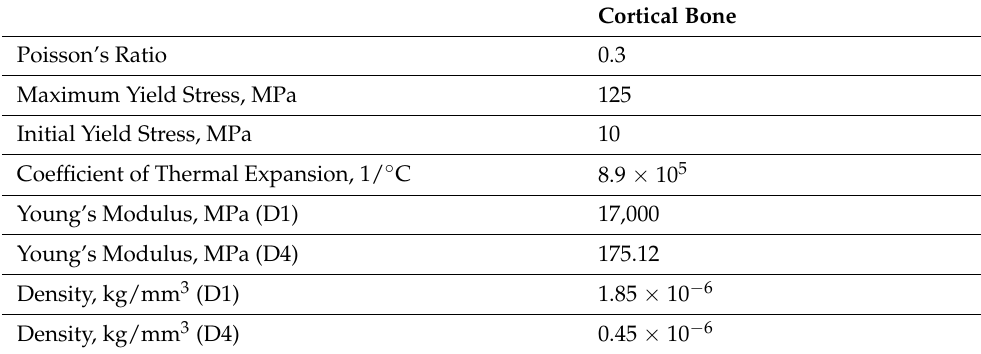
Table 2. Bone properties applied in FEA